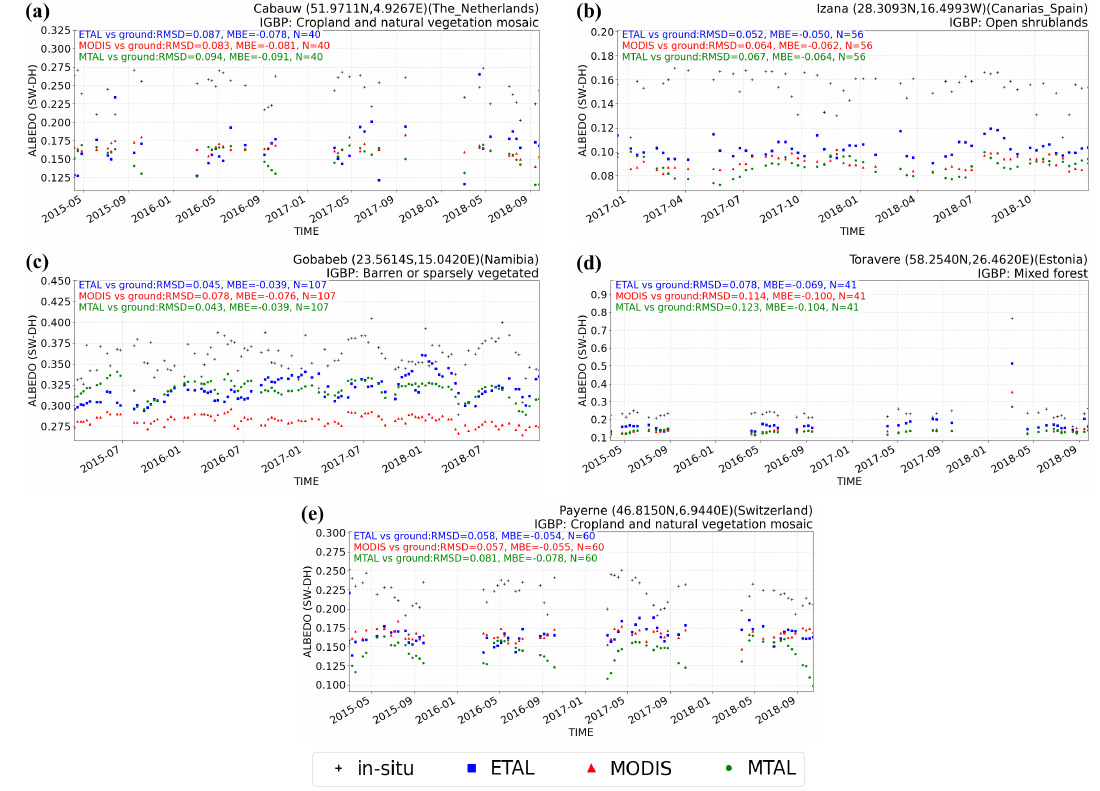
Figure 6. Time series of ETAL (ten-daily) against ground measurements (daily) for a set of ground stations: ( a ) Cabauw; ( b ) Izana; ( c ) Gobabeb; ( d ) Toravere; and ( e ) Payerne. Only those dates that provided concomitant data for all three satellites products and ground measurements were considered. Equivalent MODIS- and MTAL-R/NRT-derived albedo measurements are also presented. Difference statistics (root-mean-square deviation (RMSD) and mean bias error (MBE)) between satellite estimates and ground measurements are included. N is the number of satellite albedo estimates for which a ground measurement is available (thus, the number of estimates used to calculate the statistics).